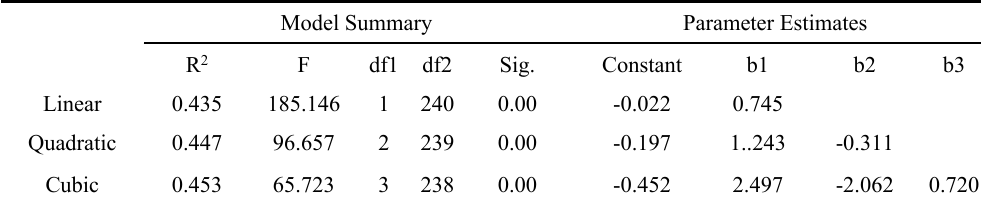
Table 4. Model Summary and Parameter